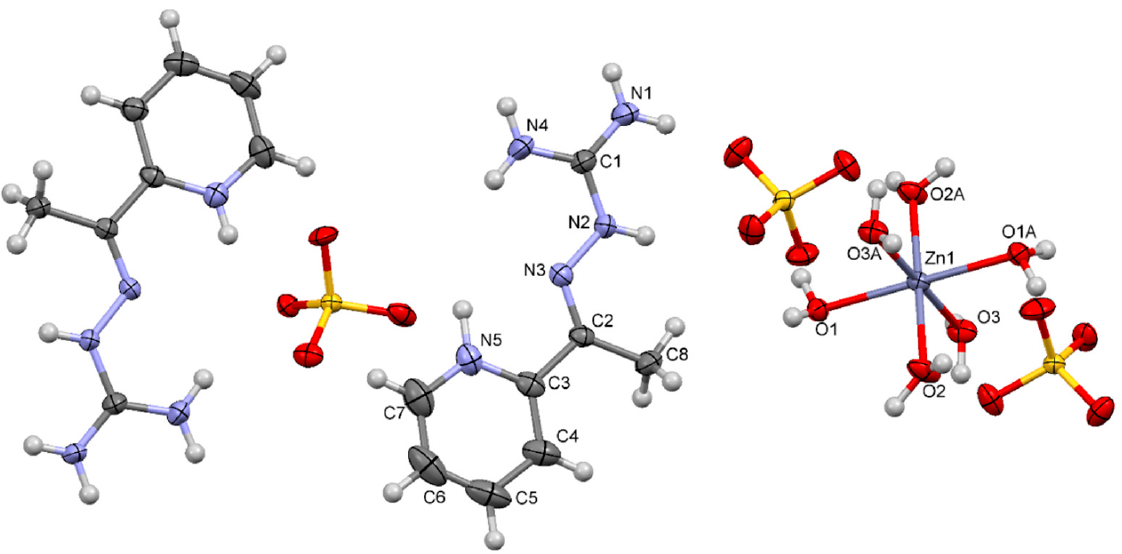
Figure 2. Molecular structure of Complex 1. Color code: H—white; C—gray, N—violet, O—red, S—yellow, Zn—dark violet .